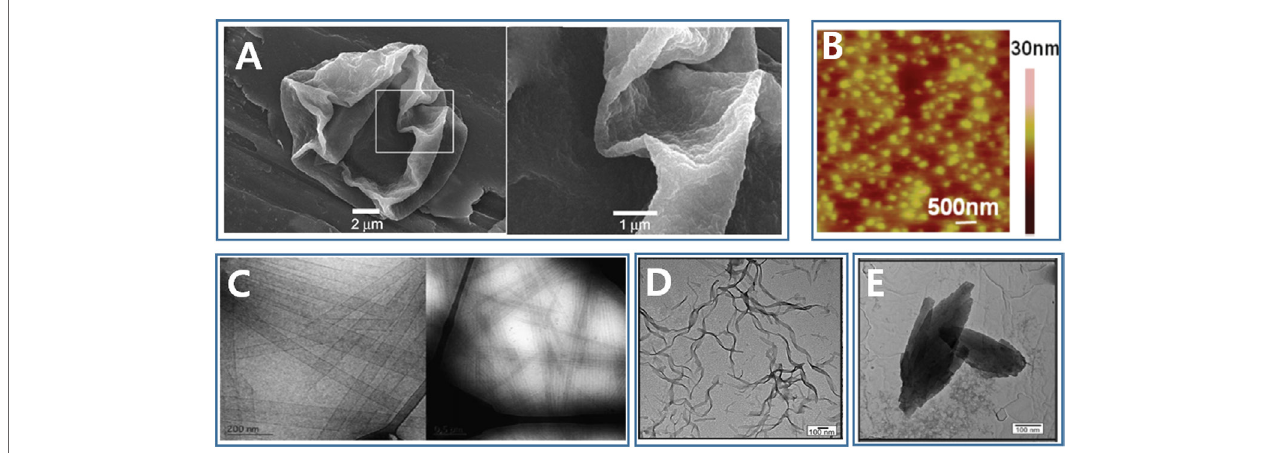
FiGURe 2 | Nano/microstructures formed through molecular self-assembly of silk-based peptide and peptide/polymer hybrid. (A) Microcapsule [Reprinted with permission from Hermanson et al. (2007). Copyright 2007 John Wiley and Sons]. (B) Nanoparticle [Reprinted with permission from Numata and Kaplan (2010). Copyright 2010 American Chemical Society]. (C) Nanotube [Reprinted with permission from Cenker et al. (2011). Copyright 2011 Royal Society of Chemistry]. (D) Nanotape [Reprinted with permission from Castelletto et al. (2014). Copyright 2014 American Chemical Society]. (e) Nanosheet [Reprinted with permission from Castelletto et al. (2014). Copyright 2014 American Chemical